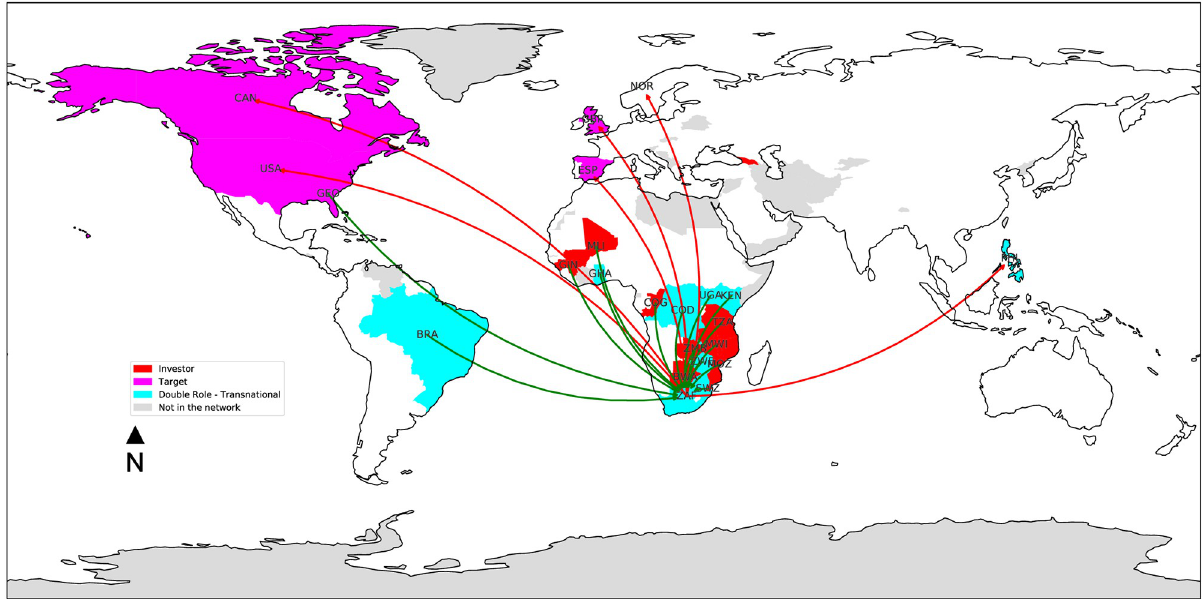
Fig 1. Focus on the ego network of South Africa. Deals seeing it as the target country (red edges) refer to investments in the sectors of food crops, renewable energies and livestock. On the other hand (green edges), South African companies invests in transnational deals (mainly in other African countries) in the same sectors, plus in different ones such as biofuels, tourism and